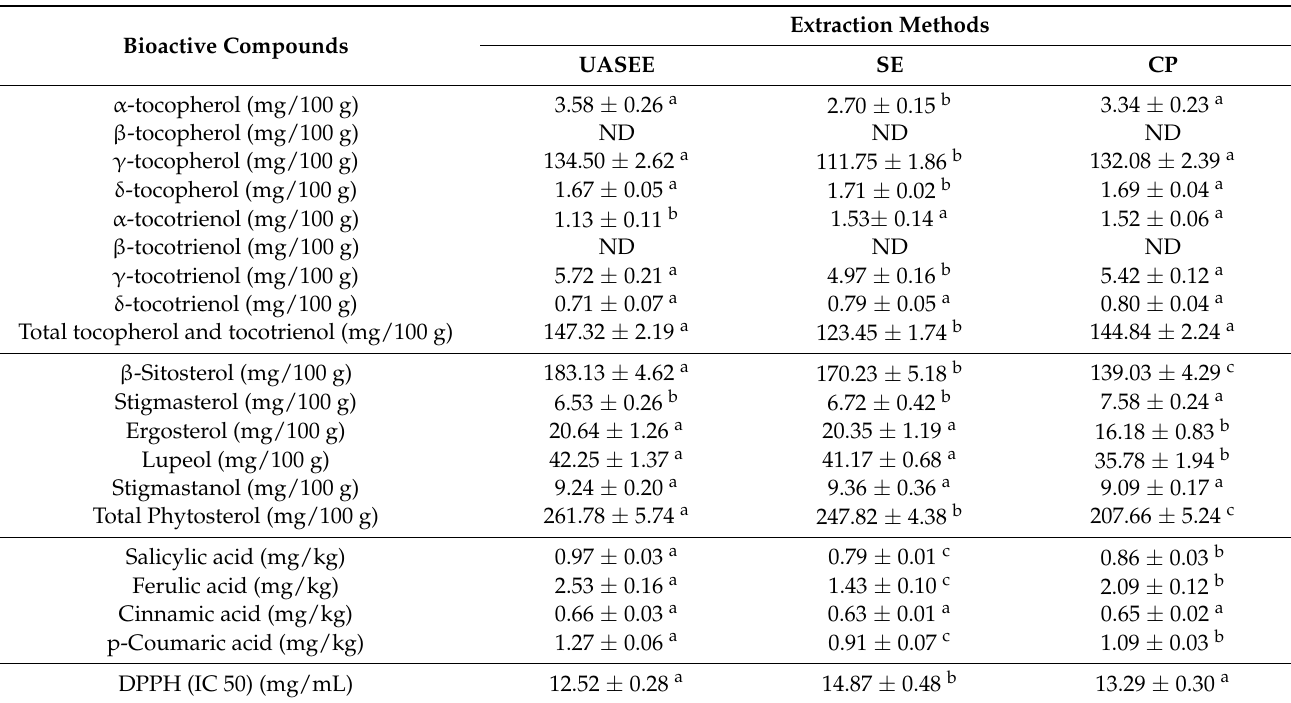
Table 4. Bioactive compounds and antioxidant activity of E.mollis oil extracted by three